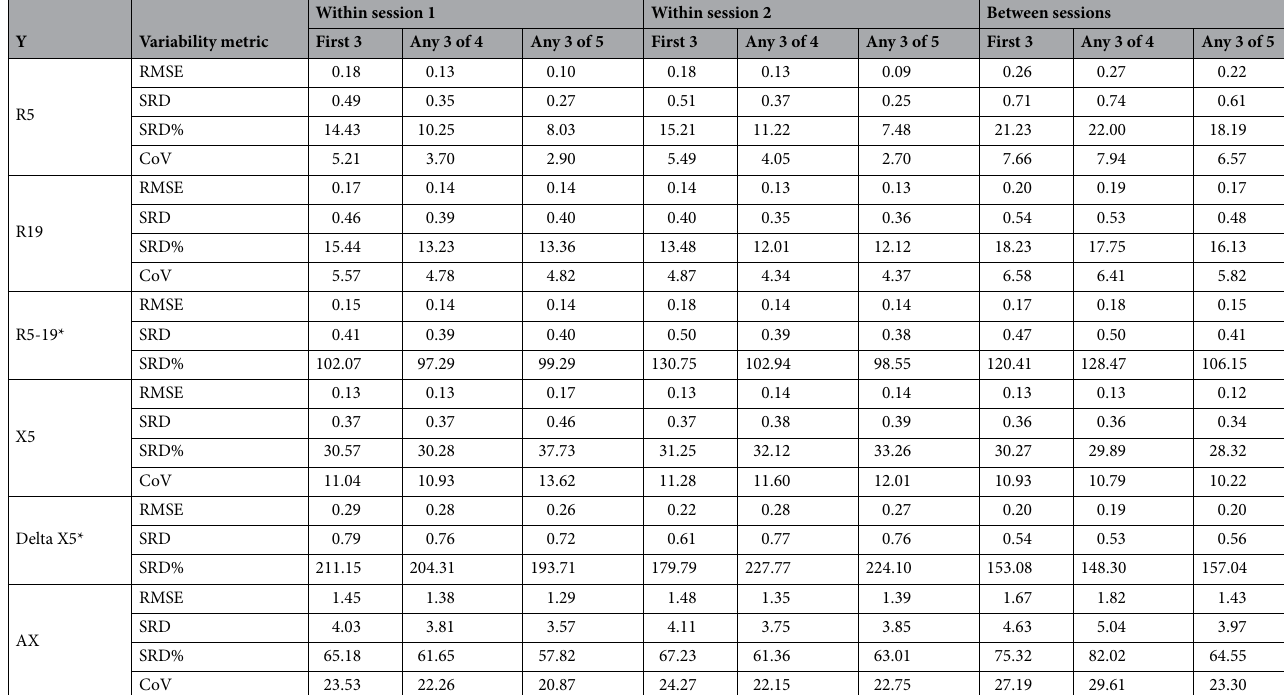
Table 2. Within and between session variability across model fit response variables (Y’s) for each trial selection method using R5 as the session validity thresholding criteria. R5, R19 and X5 = low- (5 Hz) and mid-frequency (19 Hz) resistance and reactance, respectively; R5-19 = frequency dependence of resistance; delta X5 = X5 inspiratory—X5 expiratory 14 [all in units of cm H 2 O ·s/L]; AX = reactance area [cm H 2 O/L]; RMSE = standard deviation from model fit (root mean square error); SRD = smallest real difference = RMSE × 2.7 25 ; SRD% = SRD/(mean of response) × 100; CoV = RMSE/(mean of response) × 100. * = variable spanning positive and negative values, so CoV is not calculated. Summary data for each variable, including response means used in calculations, can be found in the Supplementary Materials (Figure S1, Table